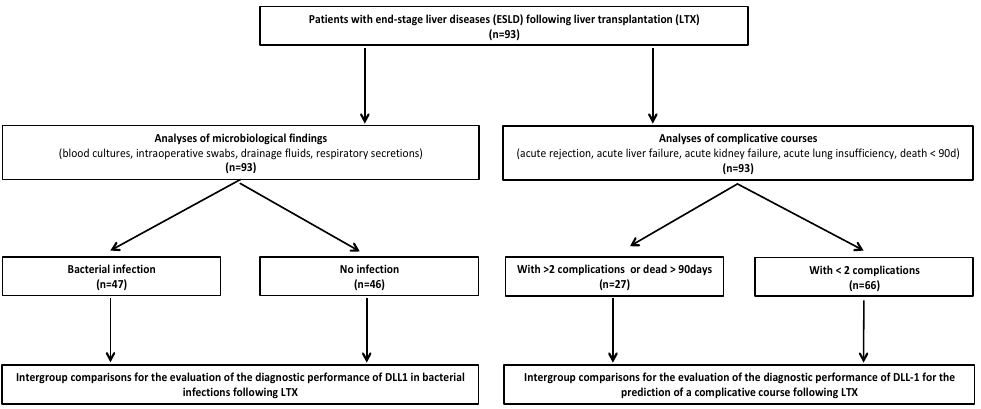
Figure 1. Flow chart of included patients. Abbreviations: ESLD, end-stage liver disease; LTX, liver transplantation.